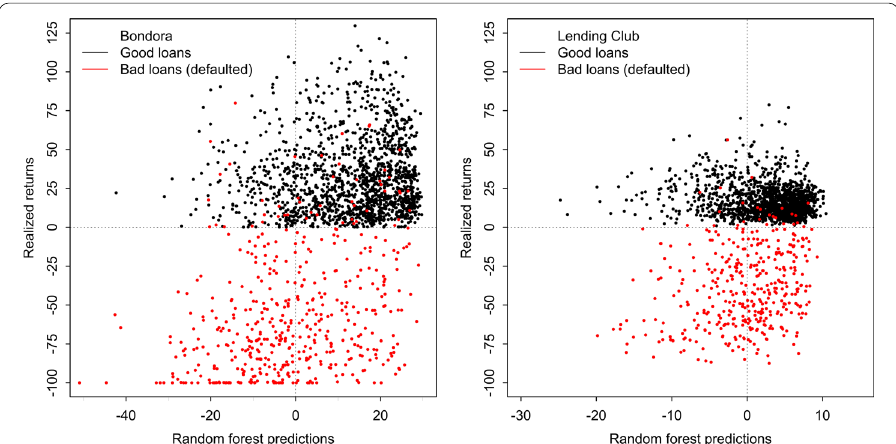
Fig. 3 Predicted and realized internal rates of returns for random forest regressions. Notes : The red point is a loan that is labeled as a defaulted loan by the P2P lending